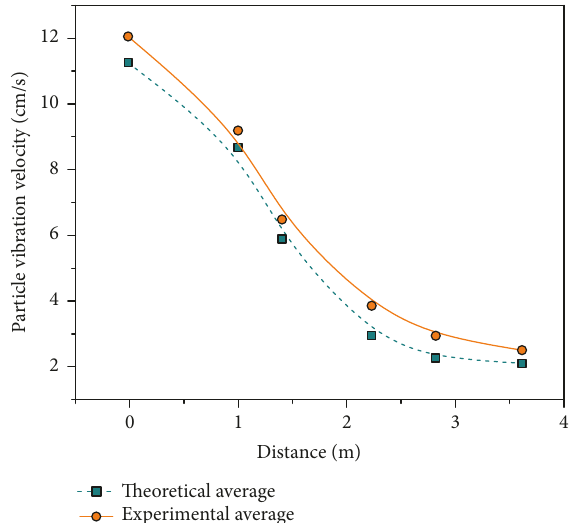
Figure 10: Experimental and theoretical curves showing accumu- lated rock mass